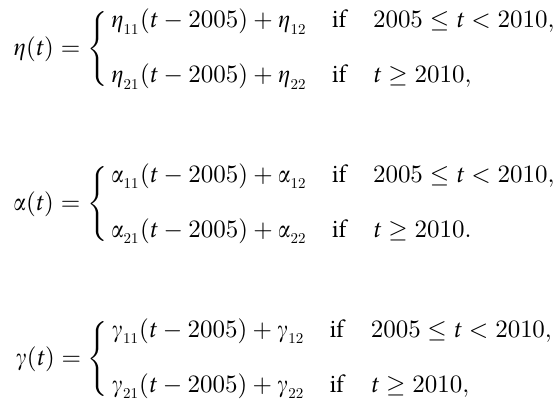
where γ ( t ) will be fitted with ART enrollment surveillance data.